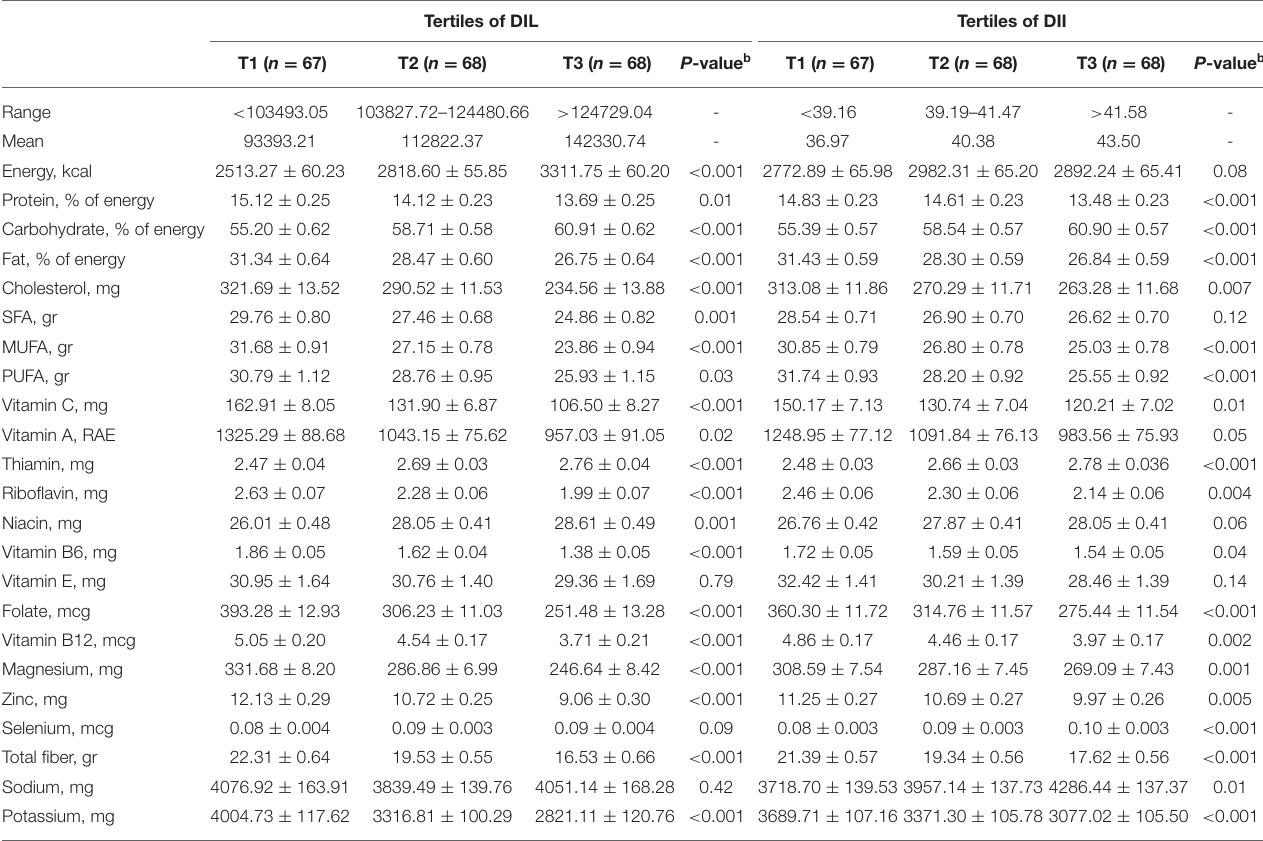
TABLE 2 | Dietary intakes (energy and macro/micro nutrients) of study participants across tertiles of DIL and DII a